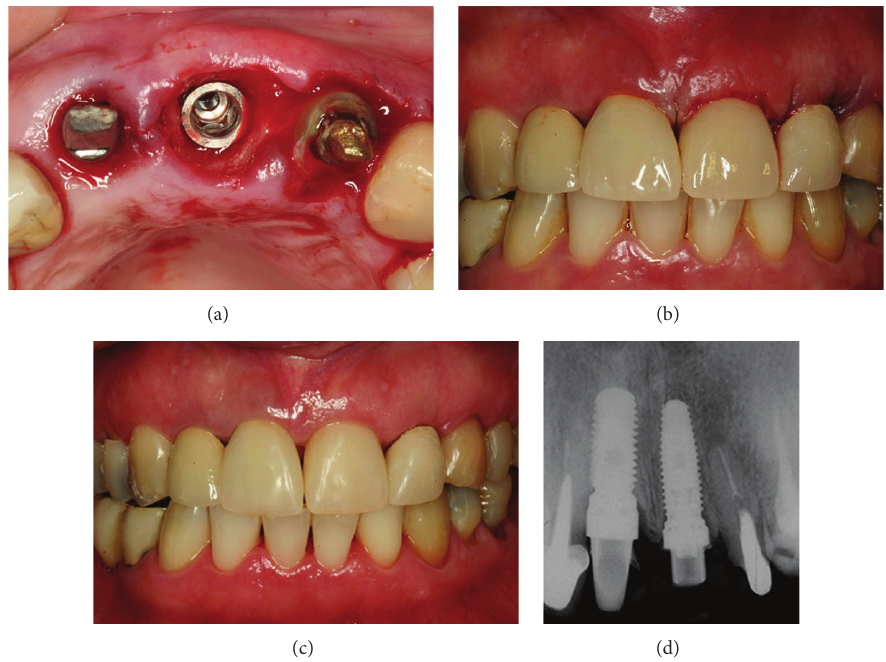
Figure 7: (a) Occlusal view of the implant placed. (b, c) Immediate postoperative views with provisional resin crown in the central and lateral incisor teeth. (d) Periapical radiography after implant installation.